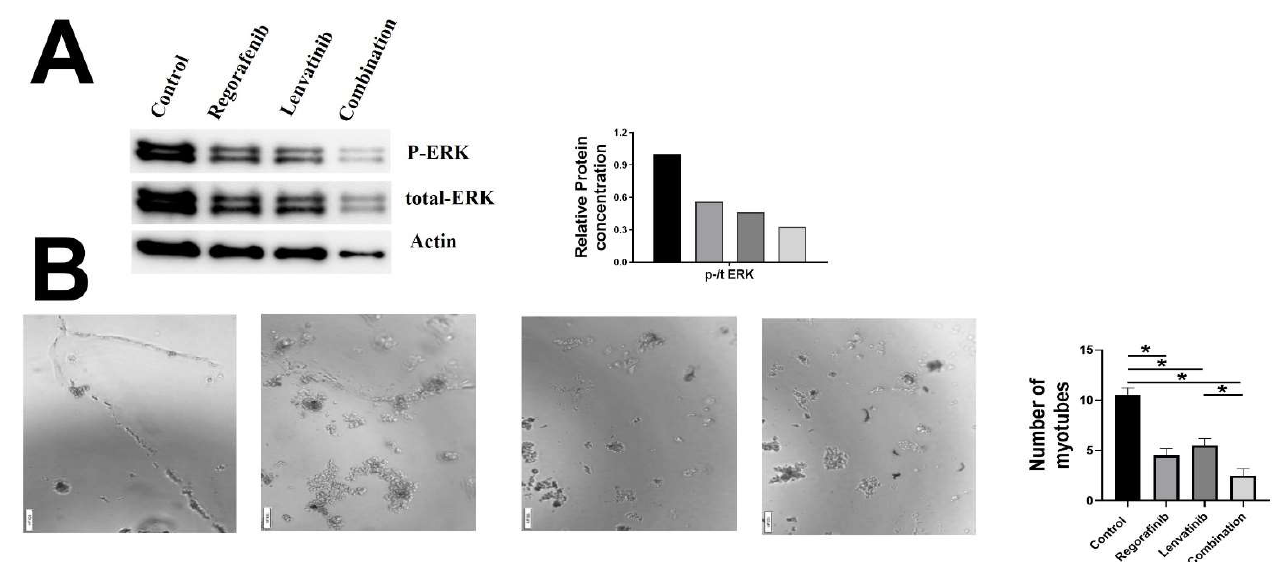
Figure 6. Effect of Regorafenib, Lenvatinib, and combination treatment on ( A ) protein levels of p-ERK, t-ERK, and ( B ) tube formation assay in the HUVEC cells. * Statistically significant, p -value < 0.05.